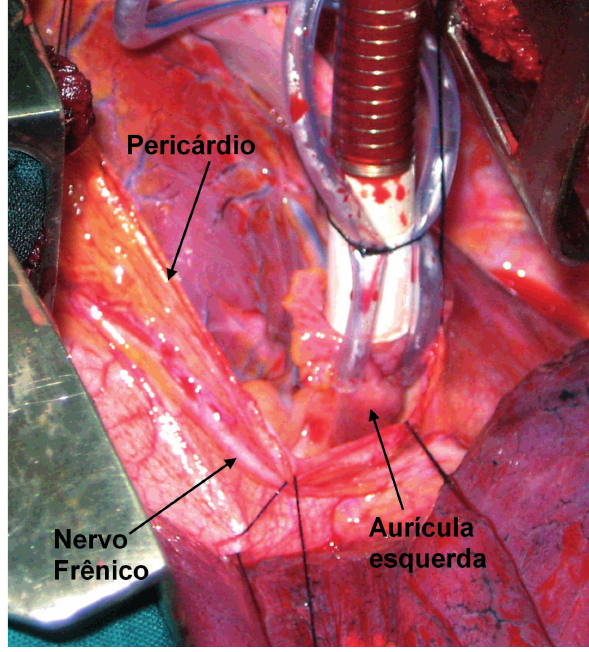
Fig. 1 - Pericardiotomia e canulação atrial esquerda. Nervo frênico Aurícula esquerda;